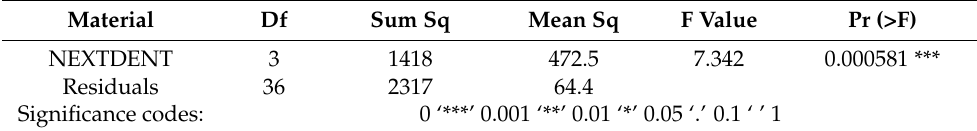
Table 5. ANOVA results of flexure strength for NEXTDENT material.